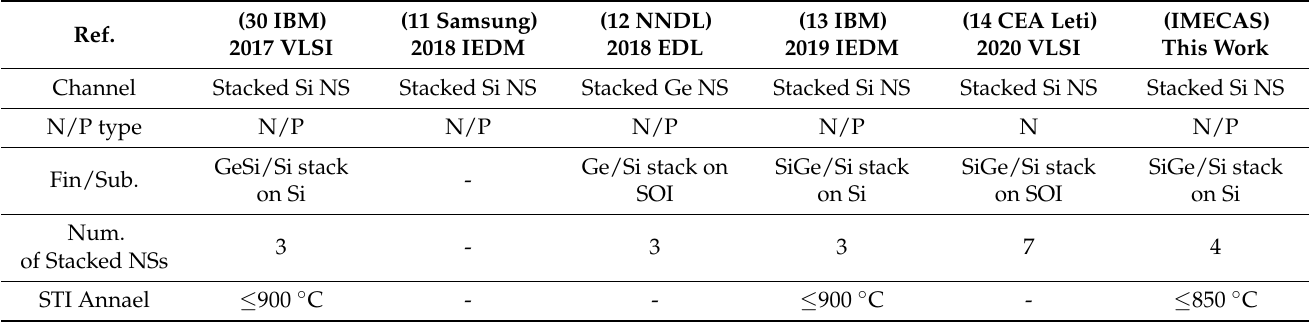
Table 2. A comparison of GAA Si NS devices in recent